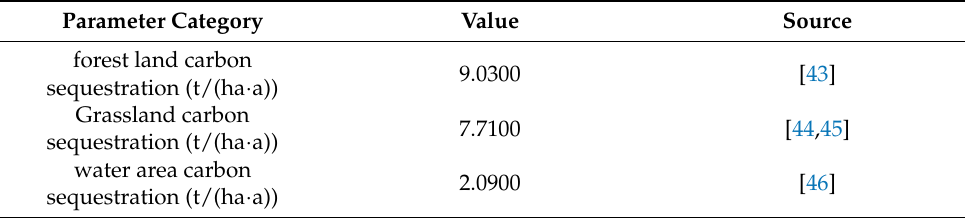
Table 2. Carbon sink